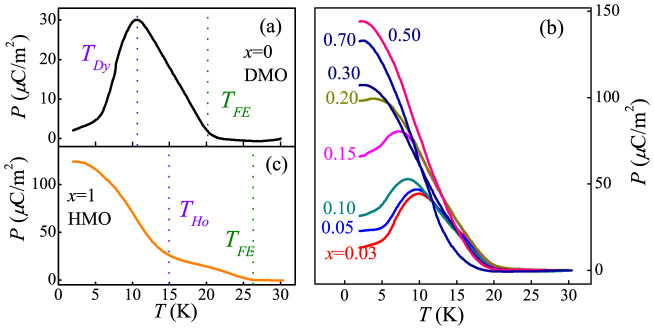
The temperature-dependent ferroelectric polarizations of the Dy1−xHoxMnO3 (0 ≤ x ≤ 1) samples: (a) x = 0, (b) 0.03 ≤ x ≤ 0.7 and (c) x = 1, respectively.